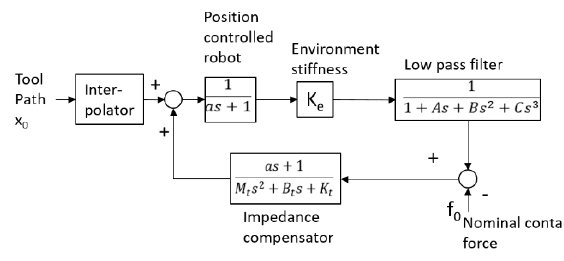
Figure 3: The schematic control system transfer functions of the impedance controlled